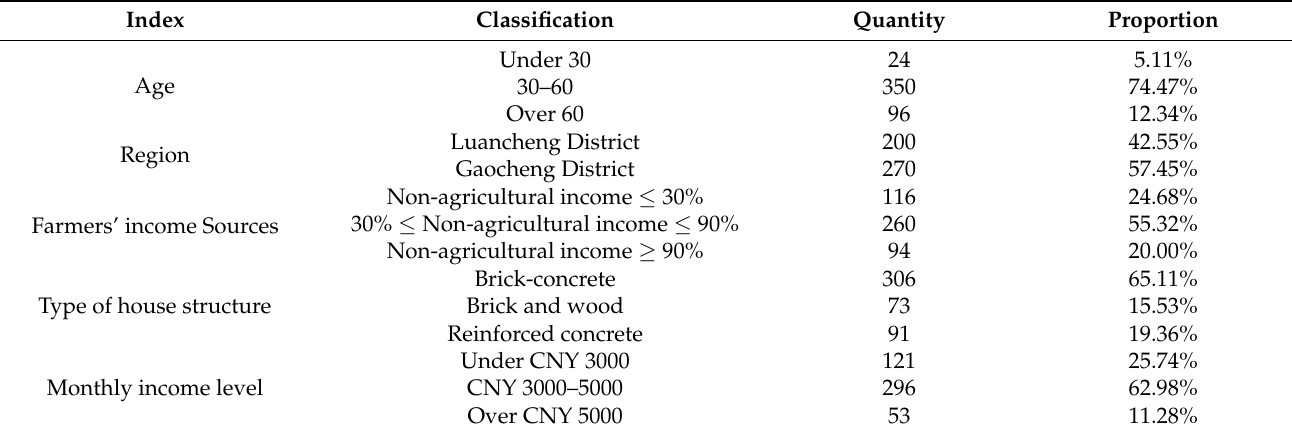
Table 3. Descriptive analysis of the basic characteristics of the